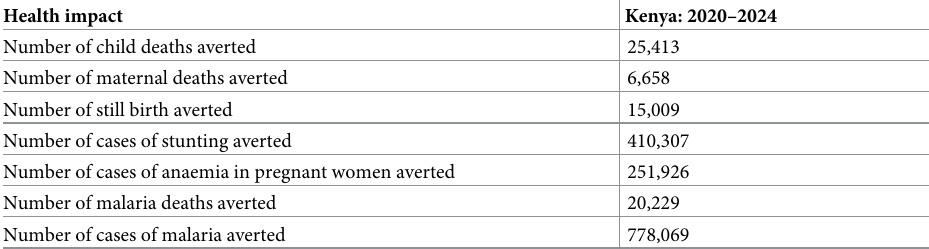
Table 3. Health impact areas of PHC intervention.